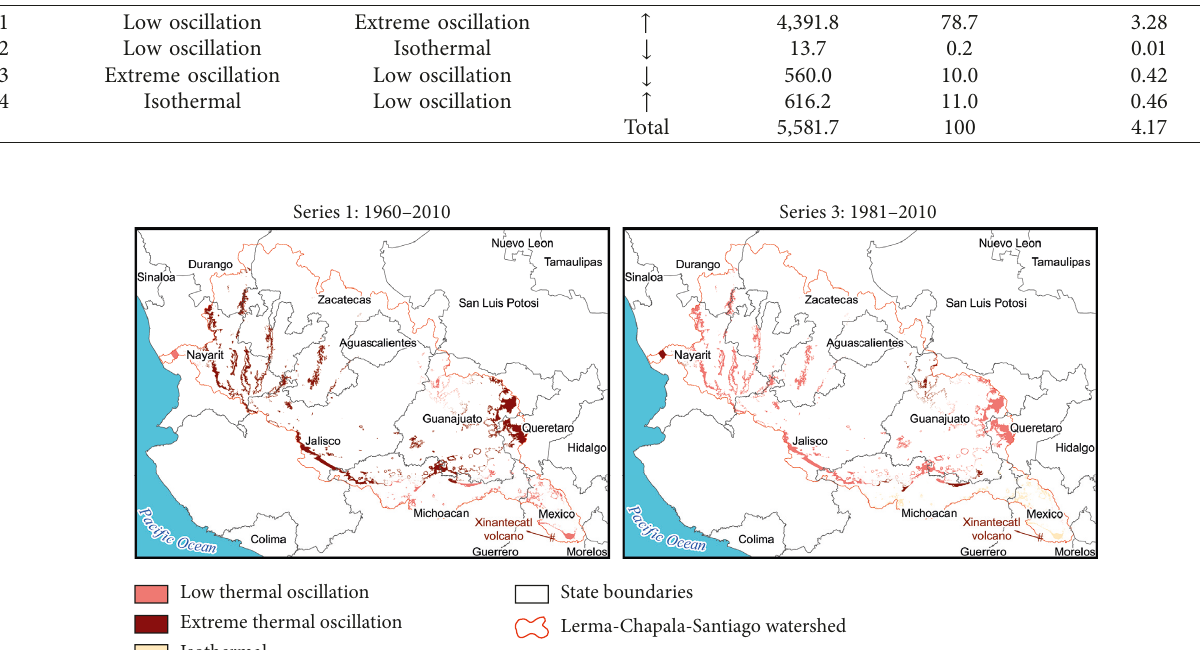
Table 3: Absolute, relative, and proportional areas of the Lerma-Chapala-Santiago watershed with changes in thermal oscillation between time series one (1960–2010) and time series two (1960–1989). No.